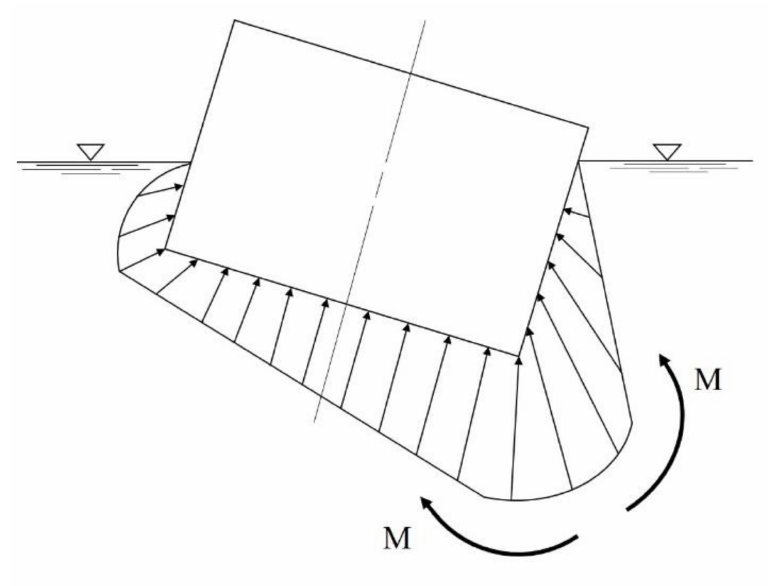
Figure 2. Load diagram of hull applied to moment.